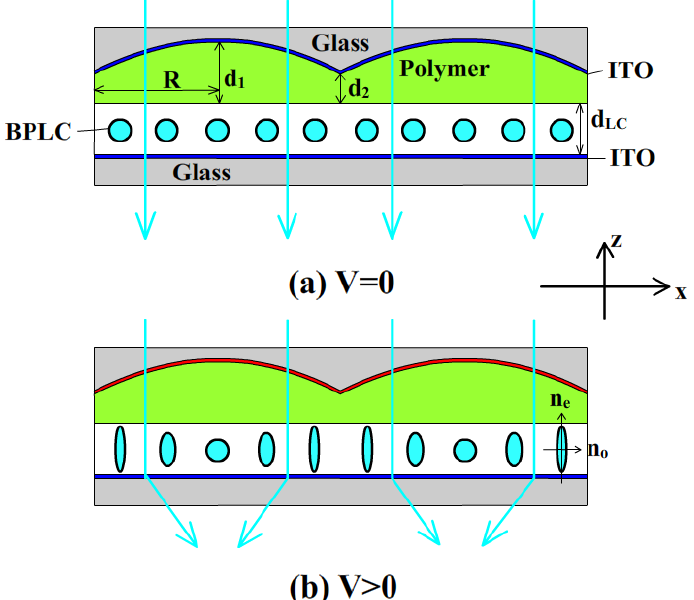
Figure 11. The configuration and working principle of a PS-BPLC microlens using a curved ITO electrode, ( a ) voltage-off state and ( b ) voltage-on state.